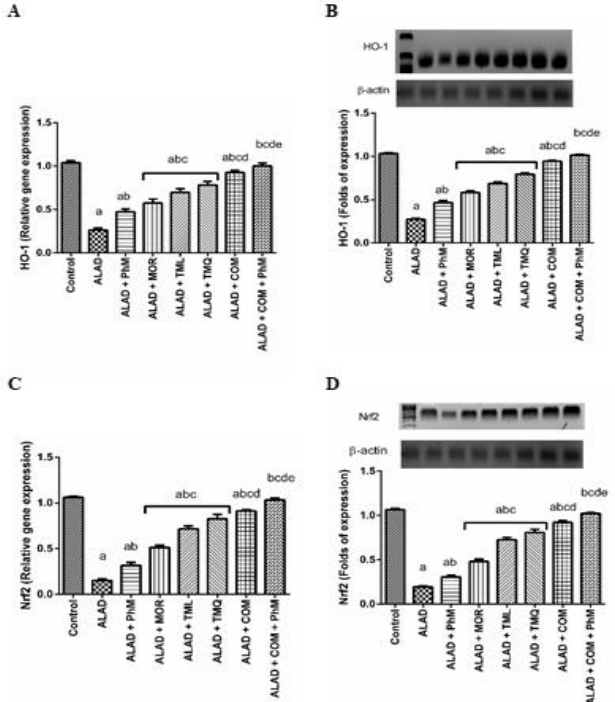
Figure 3. The effect of phytochemicals combination, MOR, TML, and TMQ, with PhM on the gene expression of HO-1 and Nrf2 and their protein levels in AD. ( A ) Relative gene expression of HO-1 , ( B ) Protein expression of HO-1, ( C ) Relative gene expression of Nrf2 , ( D ) Protein expression of Nrf2. The data are presented as means ± SD ( n = 7). Significance (a): relative to the control group. Significance (b): relative to the ALAD group. Significance (c): relative to ALAD + PhM group. Significance (d): relative to either ALAD + MOR, ALAD + TML, or ALAD + TMQ group. Significance (e): relative to ALAD + COM group Significance: p < 0.05. The data of the effect of MOR, TML and TMQ on the control are not shown as they were not